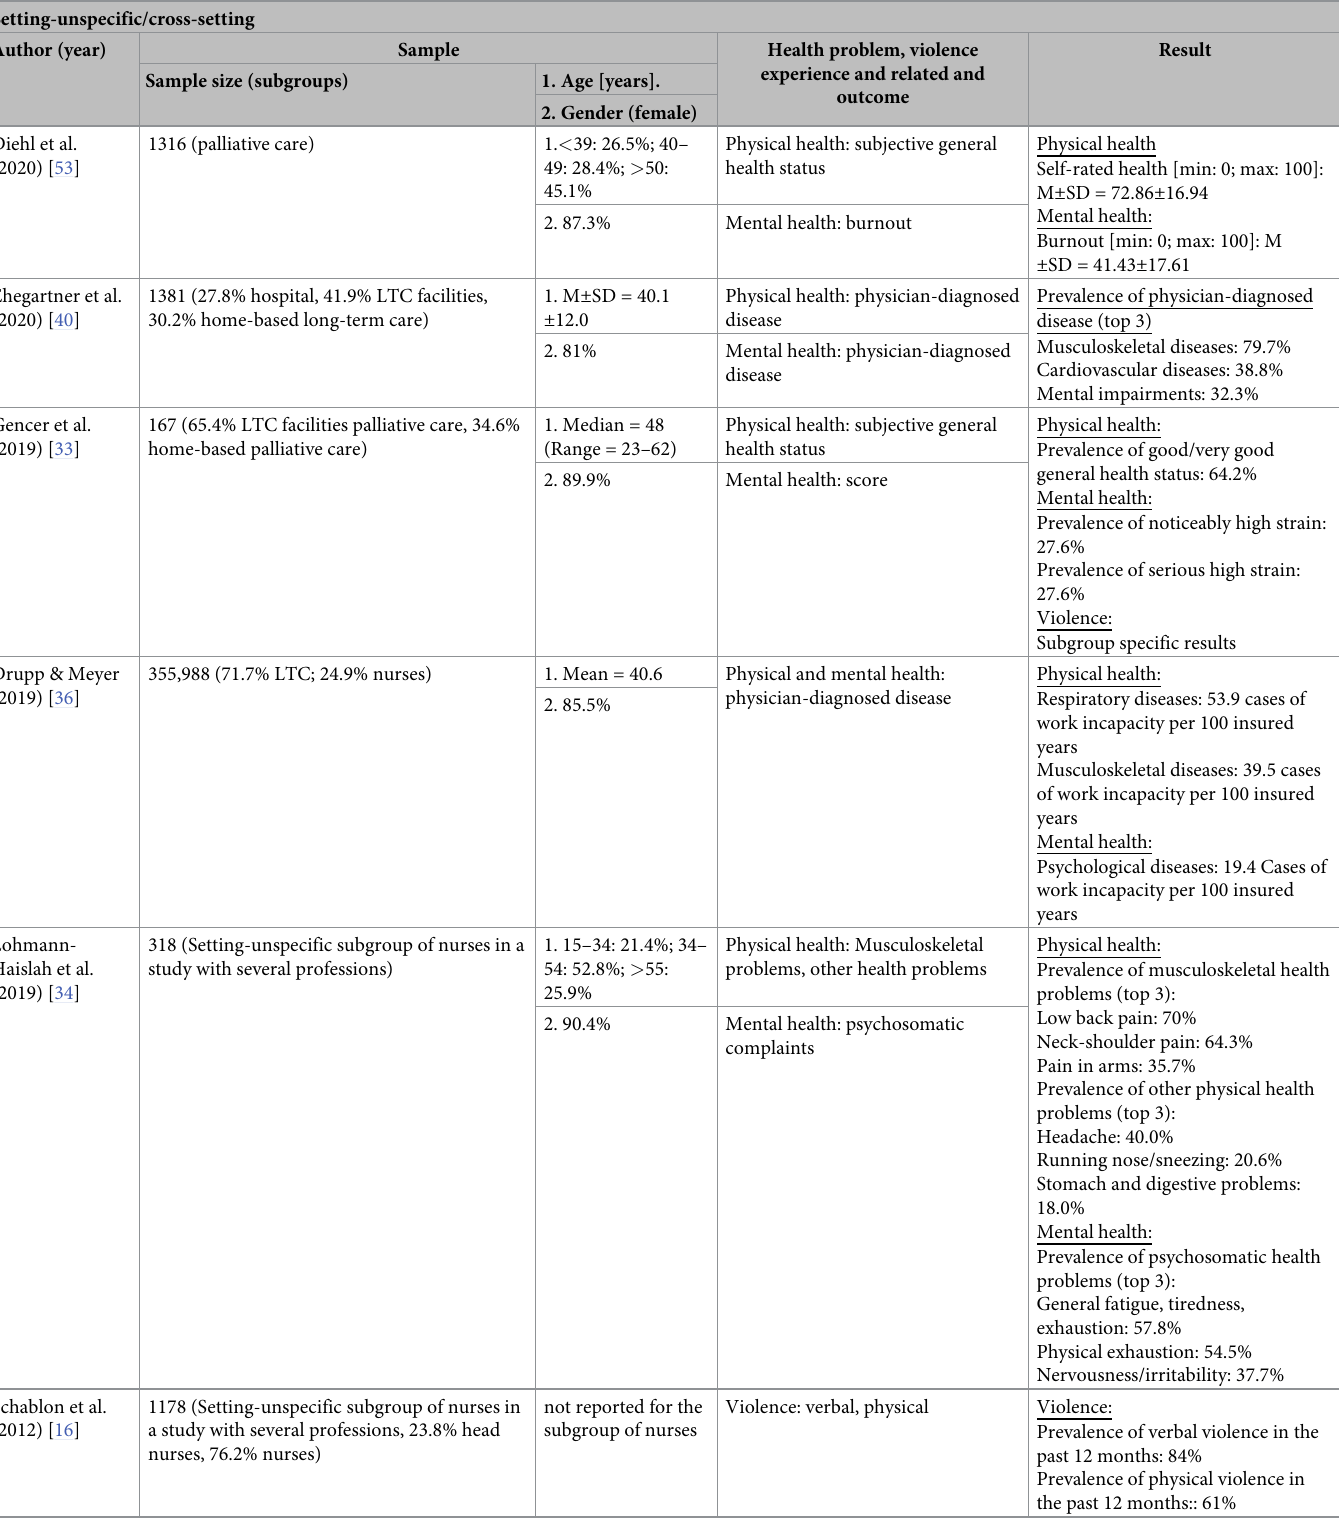
Table 1. Setting-unspecific/cross-setting—Summary of the studies included in the